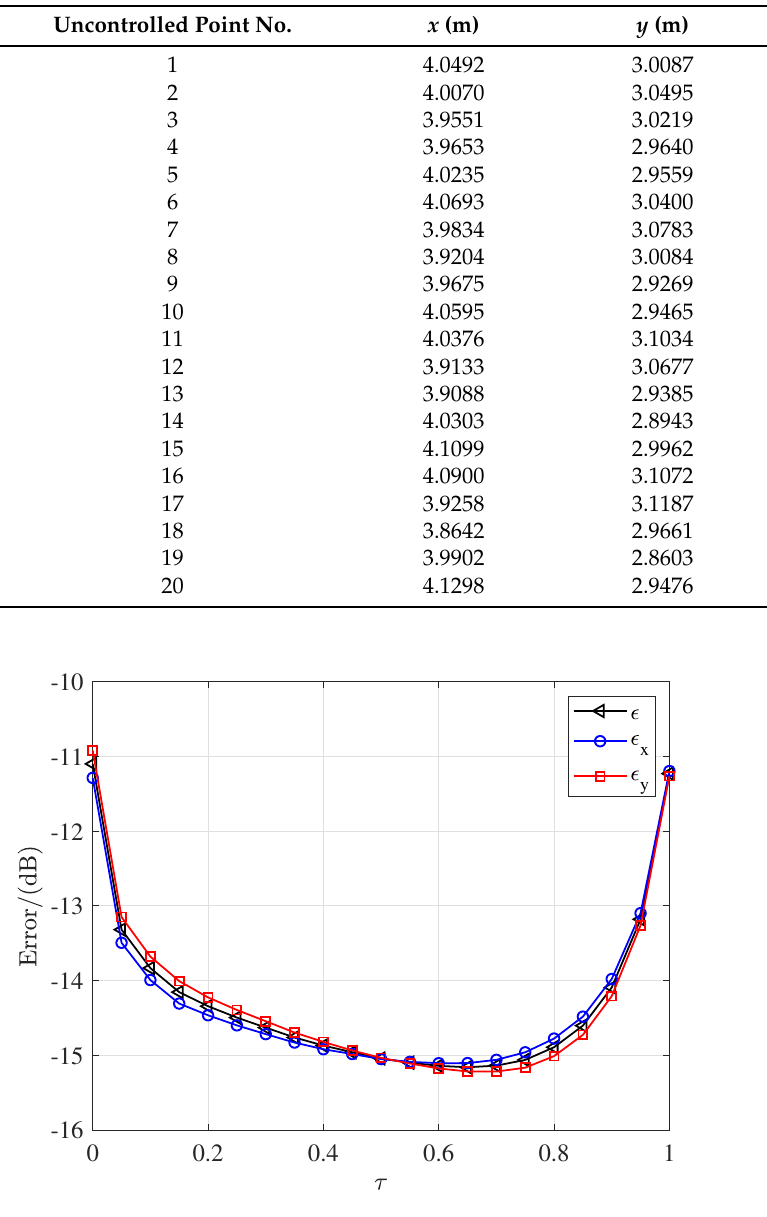
Figure 5. The NMSE of the reproduced intensity at uncontrolled points. The reverberation time RT 60 = 200 ms and the control filter length J =